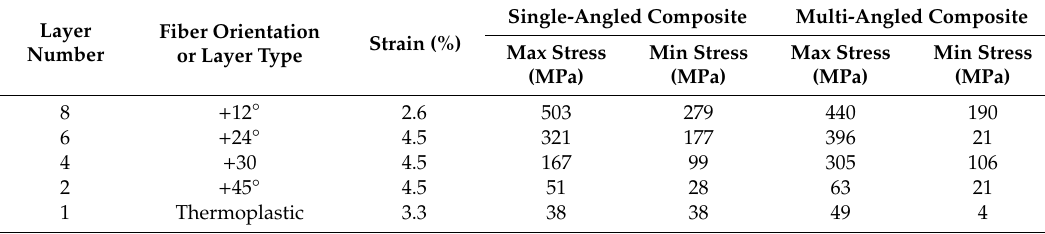
Table 7. Axial stresses in single-angled vs. multi-angled composite models for each